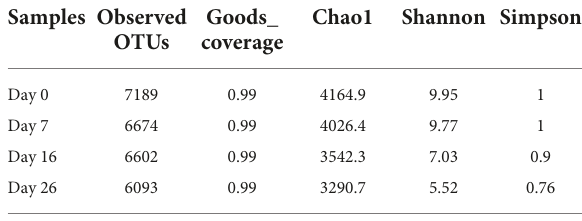
TABLE 2 Alpha diversity indices of fermented mutton sausage during natural ripening.